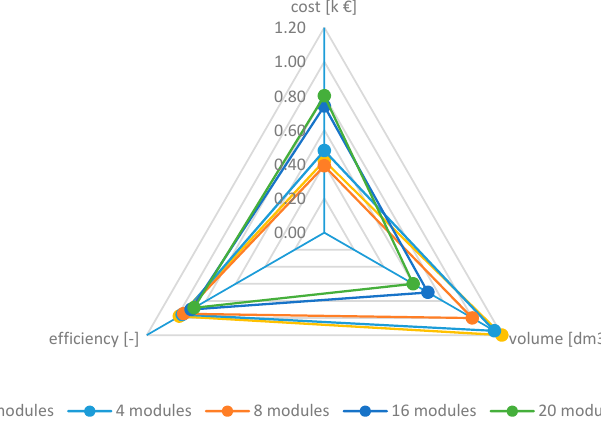
Figure9. Figure 9. Comparison of qualitative parameters for the modular concept for 500 kHz of switching frequency.